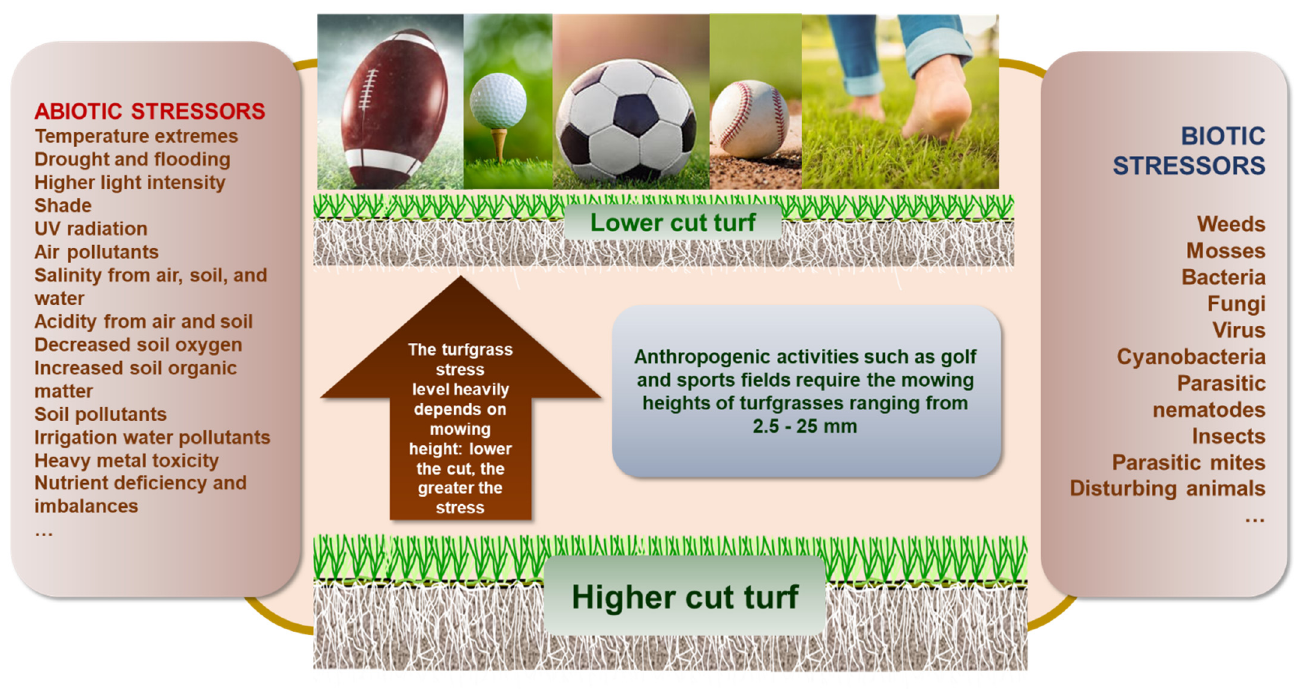
Figure 1. Turfgrasses encounter both abiotic and biotic stresses with mowing height as one of the most critical factors affecting the severity of stresses. A maintained turf area may receive more than one stress at a time or season, and it is very common that a turfgrass must be resistant to multiple stressors in addition to the lower mowing height stress for functional and performance purposes.